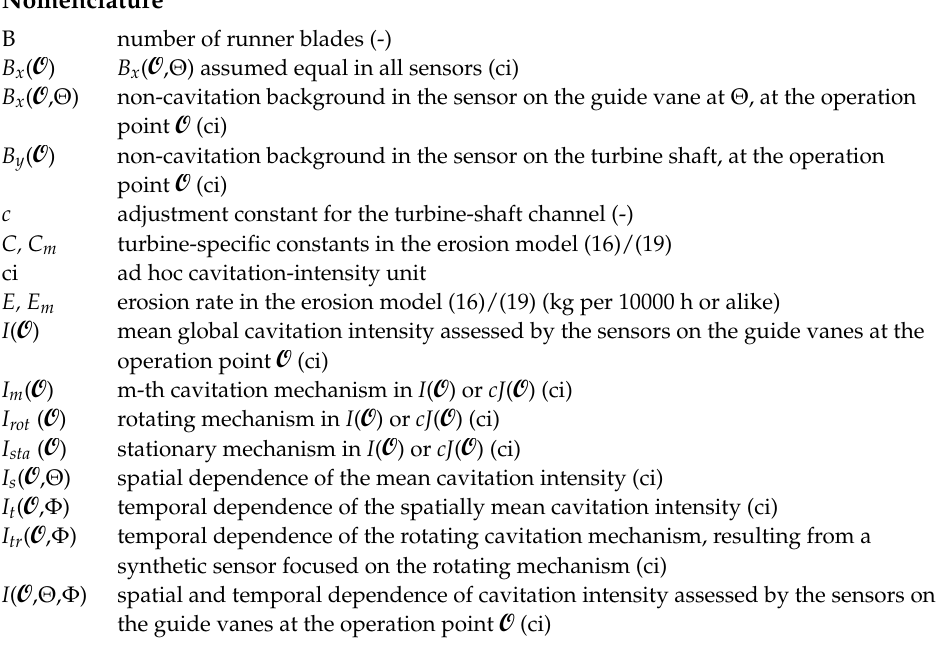
Figure 3. Front panel of the multidimensional data acquisition processor. The simplest description of cavitation comes out online after half an hour of measurement on the prototype. More compli- cated descriptions require days or weeks of recorded data analysis by a trained user.